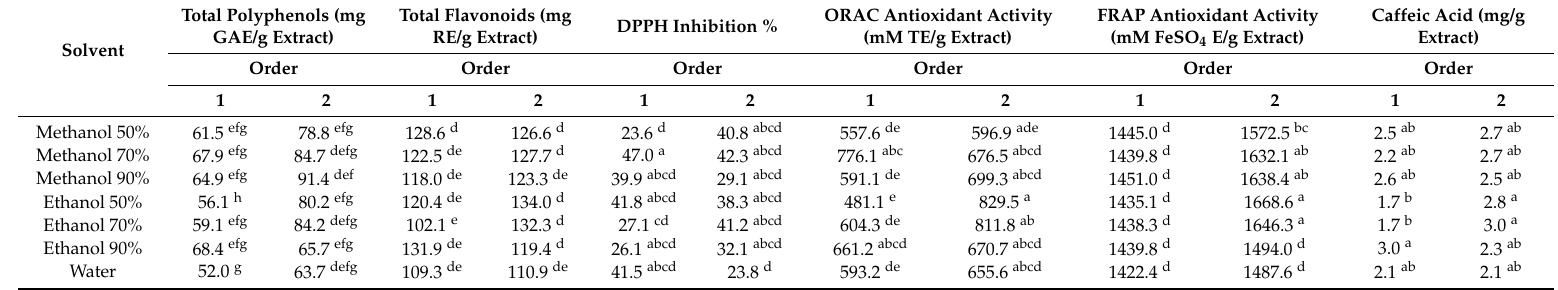
Table 2. Summary of antioxidant activities of asparagus root extract obtained from 2-h extraction. a–h Values that do not share the same letter are significantly different ( p < 0.05).